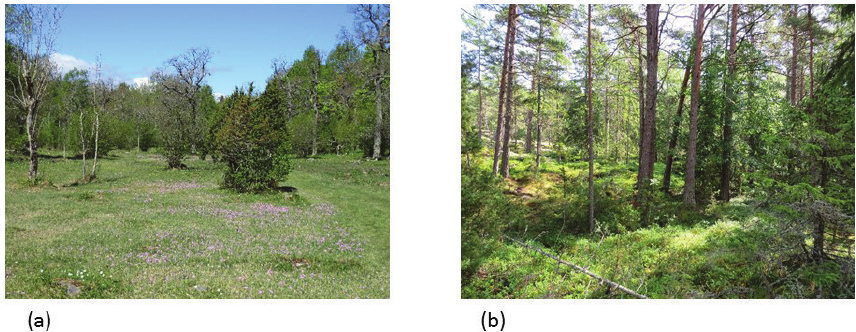
Figure 2. While remains of old agricultural management such as wooded meadows are viewed as cultural landscapes, forests usually are not. a Wooded meadow at Häverö parish, north of Stockholm, Sweden b Formerly grazed forest at Singö, north of Stockholm, Sweden. Photo: Ove Eriksson.